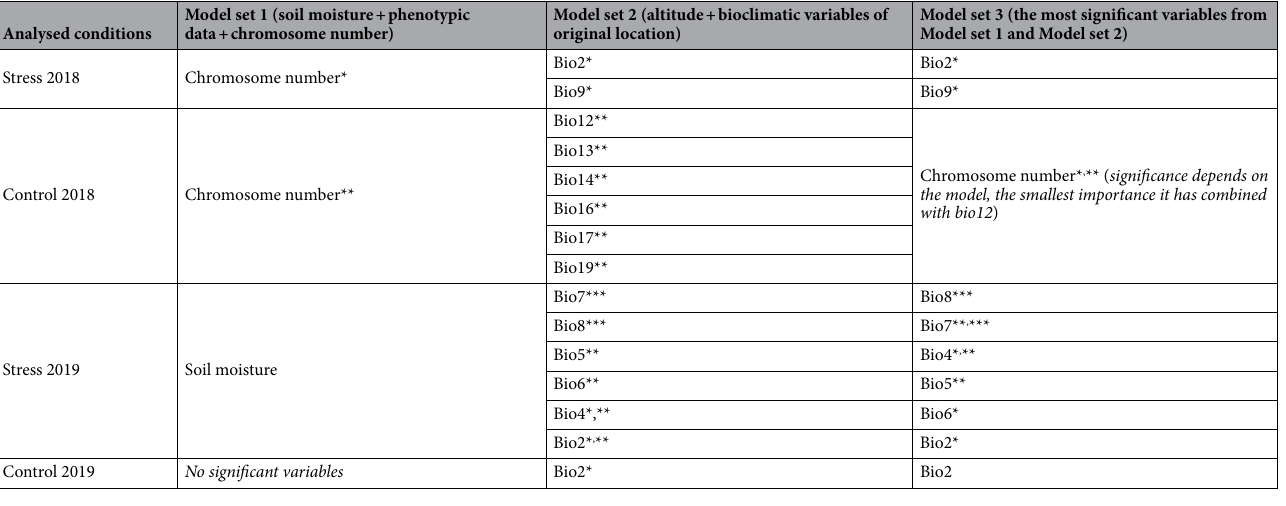
Table 1. The most significant factors influencing global methylation level in the common garden experiment with F. amethystina and F. tatrae accordingly to stepwise regression. Calculations were performed separately for three types of data sets, detailed results are included in Supplementary Tables S2–S5. Significance codes: ***< 0.001; **0.001; *0.01; none >